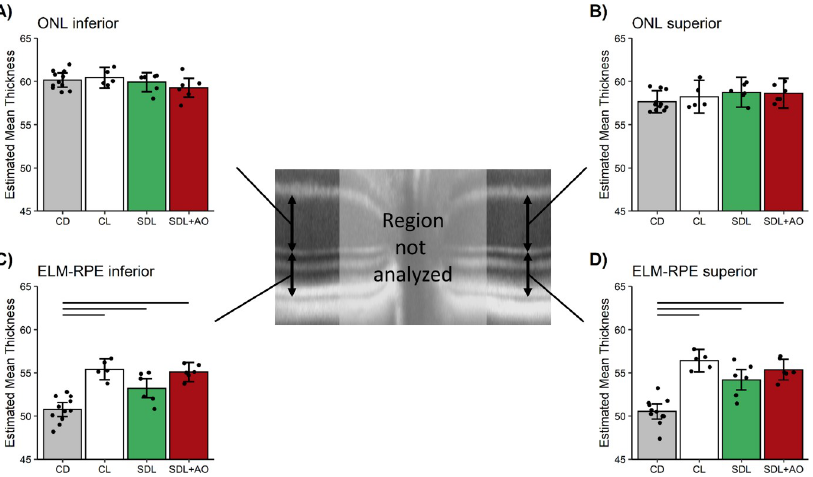
Fig 6. 5 hr post-sildenafil in light-adaption mice (SDL, Fig 2) shows light-like ELM-RPE. Modeled A) ONL inferior retina, B) ONL superior retina, C) ELM-RPE thickness inferior retina, and D) ELM-RPE thickness superior retina in uninjected control dark (CD, n = 11 mice, grey bar), control light (CL, n = 5 mice, white bar), SDL+saline (SDL, n = 6 mice, green bar), and SDL+AO (n = 6 mice, red bar) in the two different retinal regions. ONL is unresponsive to condition. In SDL+saline and SDL+AO groups ELM-RPE thickness is not different from CL (and was thicker than CD); no evidence for oxidative stress was found. The points in each plot represent the estimated mean for each mouse based on the model. Error bars indicate 95% confidence intervals. Note the same control bars are presented in each graph to facilitate